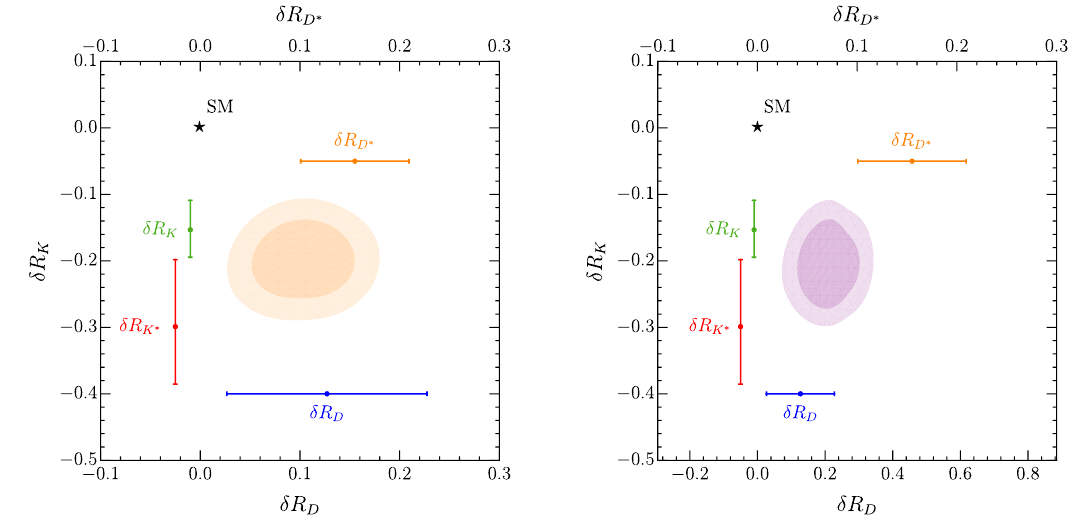
and δR [1 . 1 , 6] resulting from the low- Figure 6 . Preferred 1 σ and 2 σ regions for the ratios δR D ( ∗ ) K energy fit for β bτ = 0 (orange) and β bτ = − 1 (purple). Note that in both cases δR ∗ ≈ δR K to a very R R K good approximation. The colored error bars show the current experimental measurements at 1 σ